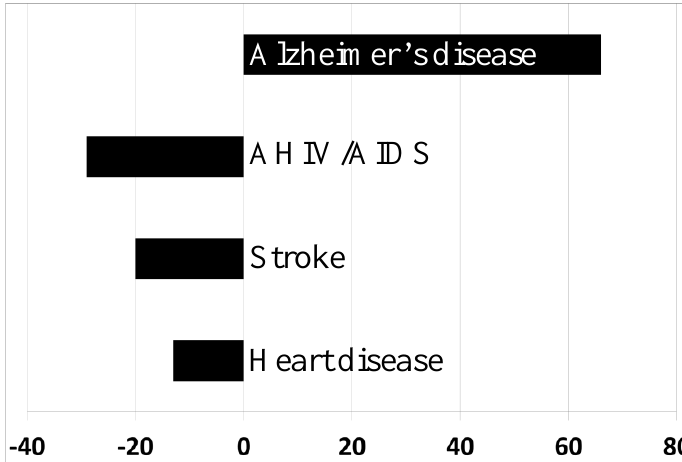
Figure 1. Changes in disease-related deaths (%). Numbers of deaths caused by HIV, stroke and heart disease-declined substantially between 2000 and 2008. Within the same time period, AD-related deaths increased more than 65%. Adapted from